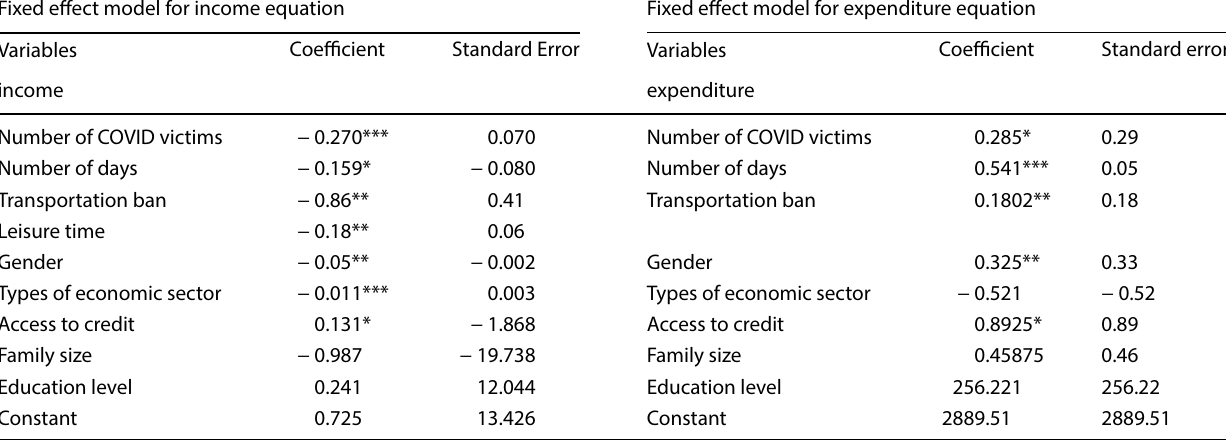
Table 6 Fixed effect estimation result for income and consumption